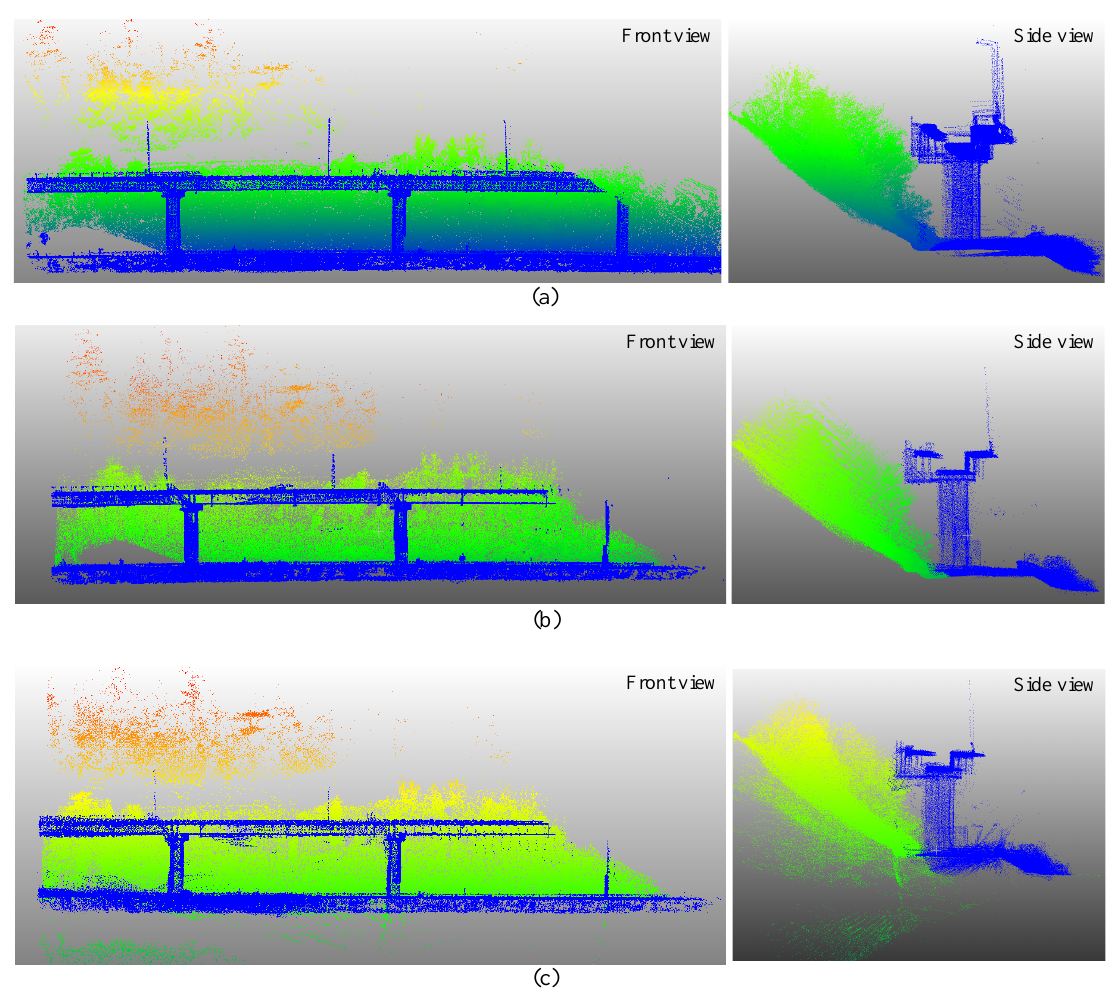
Figure 11. Front and side views of the final 3D maps of Deungseon Bridge obtained using our method vs. LOAM vs. LIO-mapping: ( a ) Our method, ( b ) LOAM, and ( c )